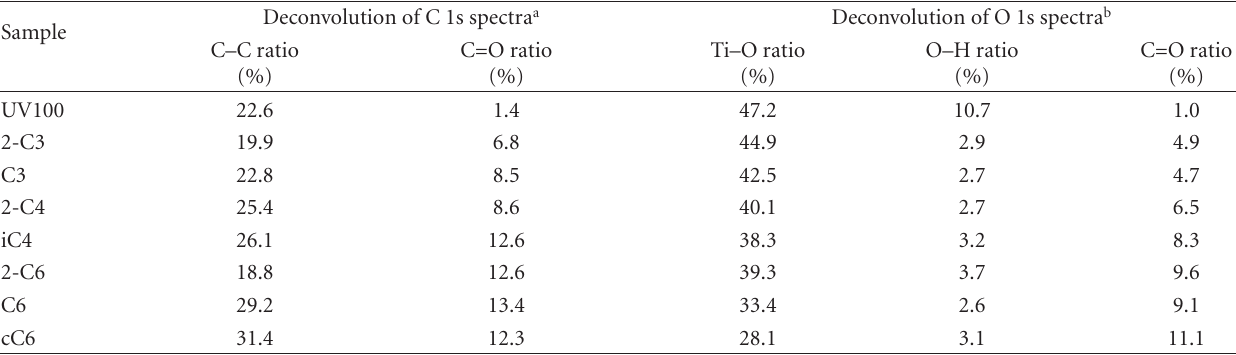
Table 3: Deconvolution results of C 1s and O 1s spectra from XPS analysis.